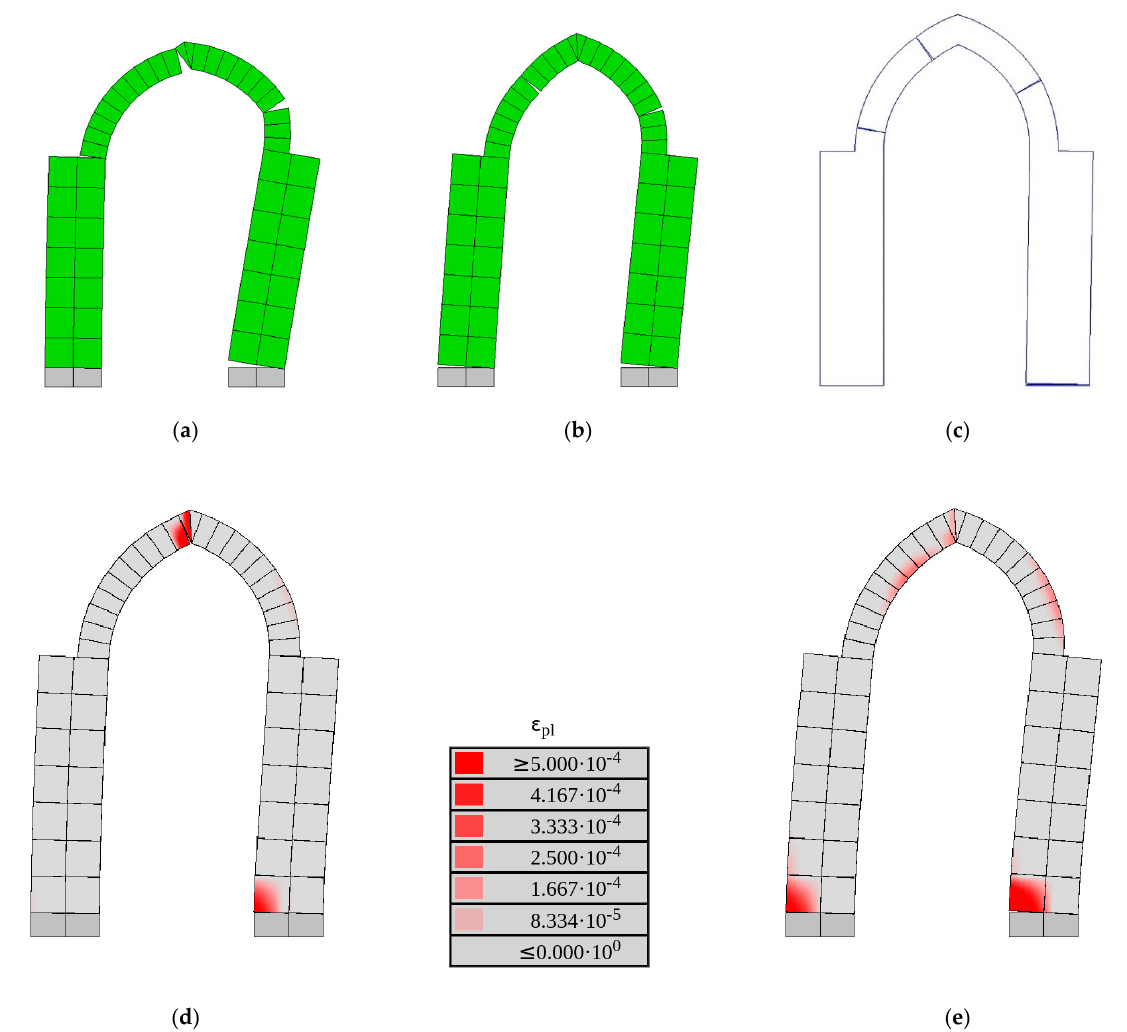
Figure 11. Comparison between DMEM and limit analysis: ( a ) DMEM deformed shape at failure for all models except Model 1, ( b ) Model 1 DMEM deformed shape at failure, ( c ) limit analysis hinge position, ( d ) peak load plastic strain for weak masonry with f t = 0.1 MPa, G t = 0.01 N/mm, and ( e ) peak load plastic strain for weak masonry with f t = 0.1 MPa, G t = 0.05 N/mm.